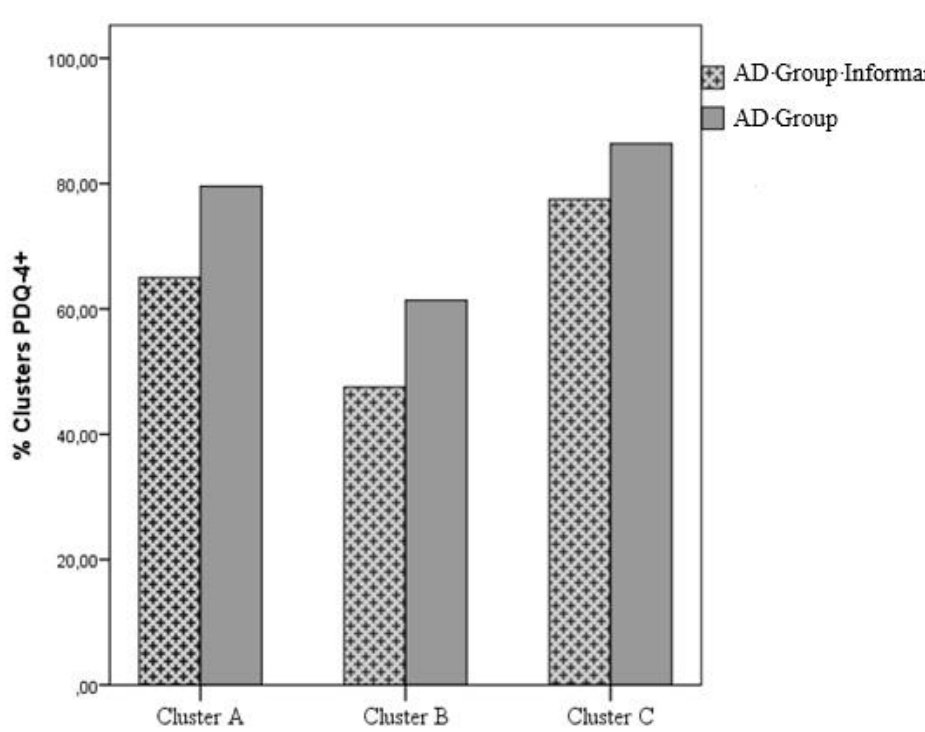
Figure 1. Bar graph of the percentage distribution of the three PDQ-4+ clusters in AD Group Informants and AD Group. Table 3. Chi-square Test of Homogeneity between the AD Group Informants and the AD Group for Diagnosis of the Ten Scales of the